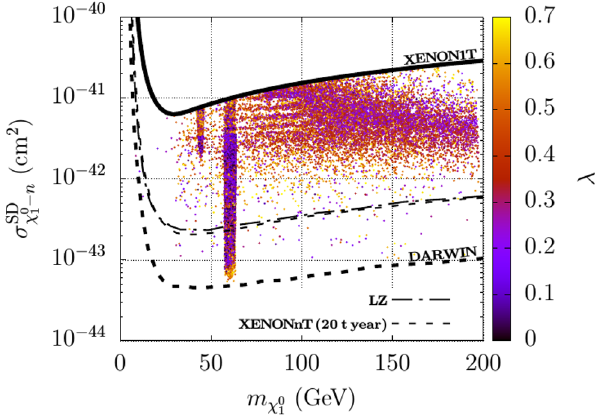
Figure 9 . Same as in the bottom, right plot of figure 8 but for SD rate along the